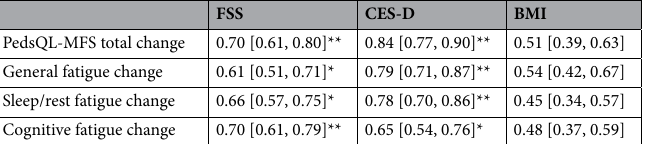
Table 6. AUC values predicting improvement in FSS and CES-D from change in PedsQL-MFS total and subscales. * p < .05. ** p < .001.